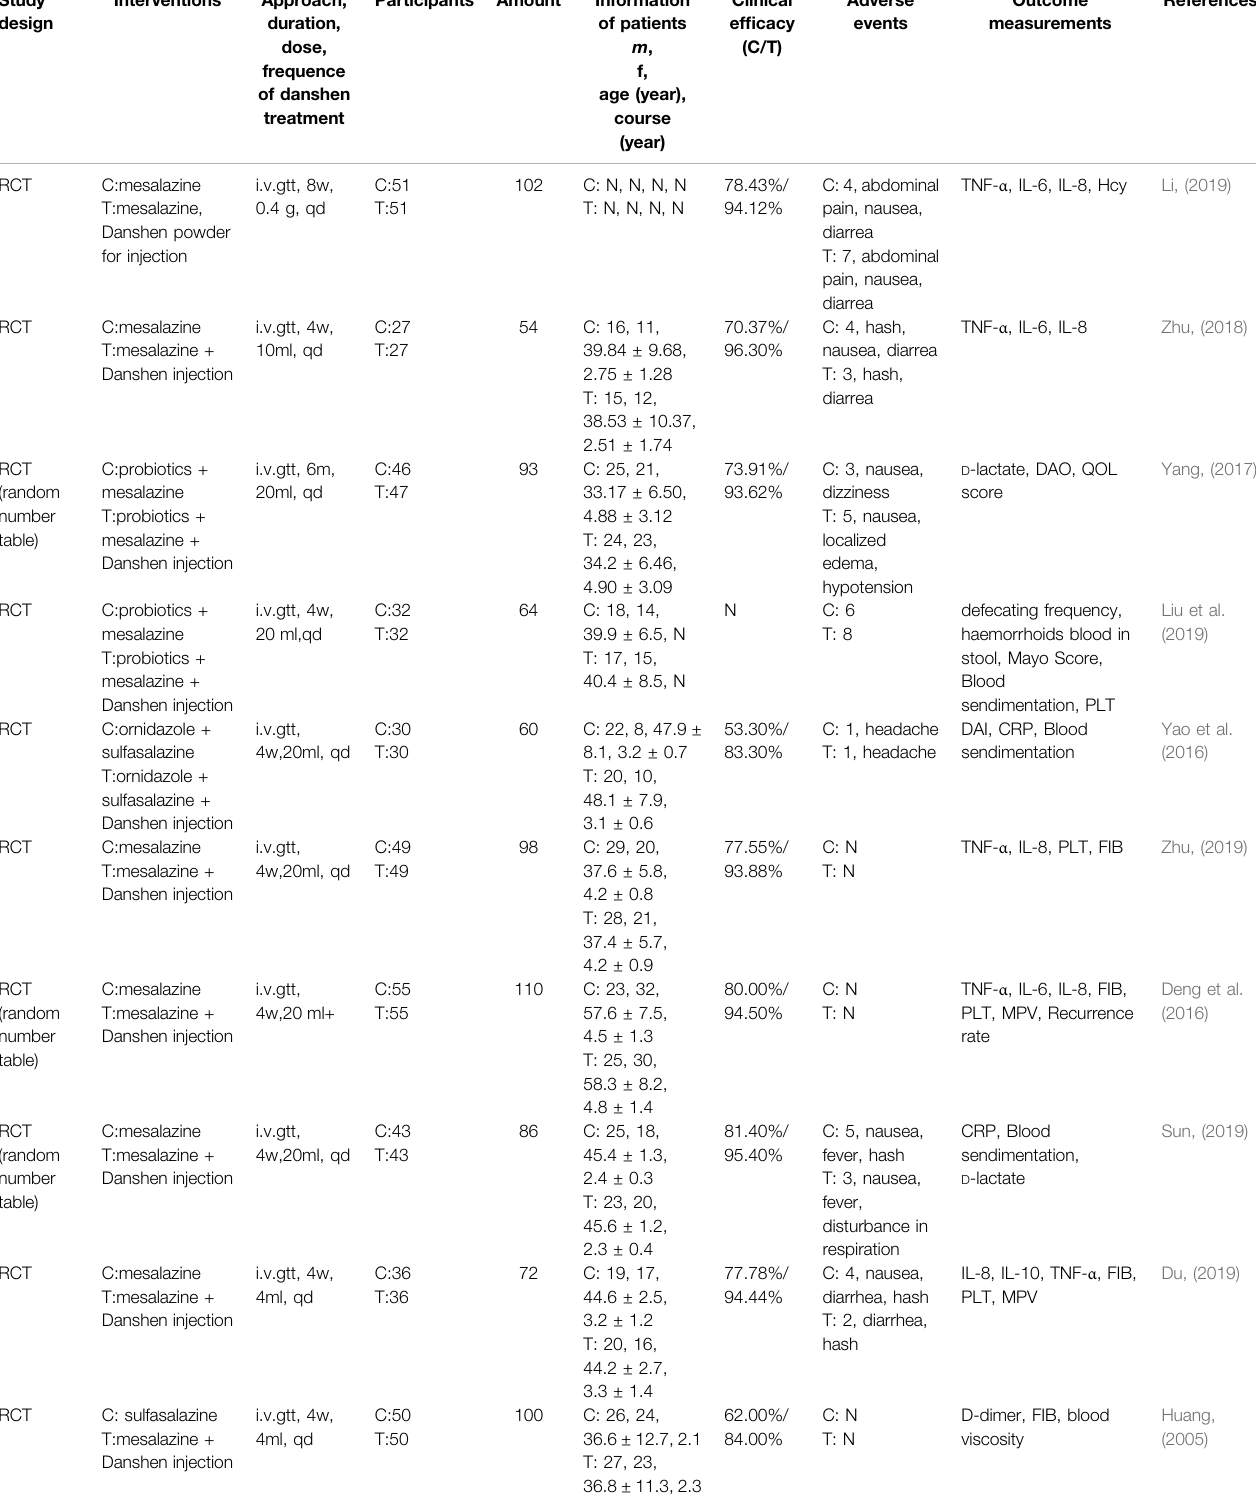
TABLE 3 | Clinical trials of Danshen products as supplementary interference in the regulation of ulcerative colitis (UC) (Hydrophilic cluster). Study